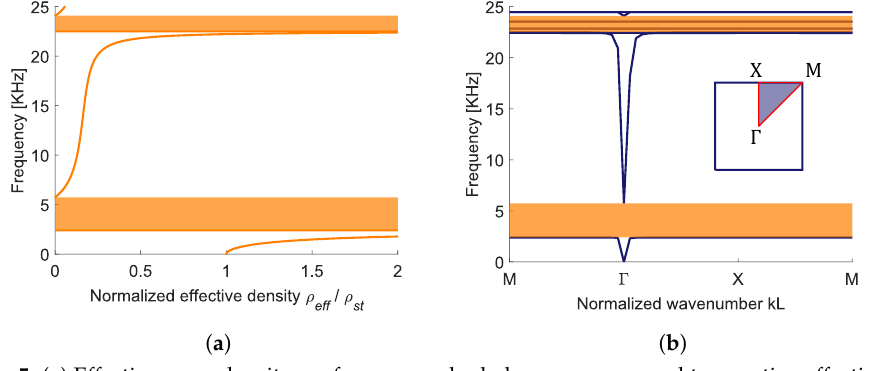
Figure 5. ( a ) Effective mass density vs. frequency, shaded areas correspond to negative effective mass, ( b ) dispersion plot with shaded band gaps obtained from the numerical Bloch-Floquet’s analysis; Irreducible Brillouin Zone and path followed for the numerical analysis is reported in the